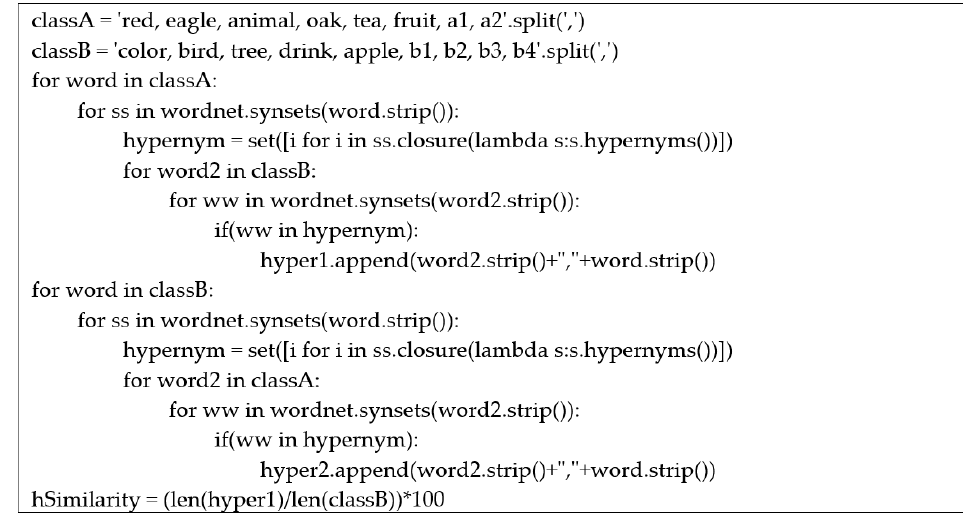
Figure 5. Algorithm for calculating hypernym similarity between classes “A” and “B” and classes “B” and “A”.